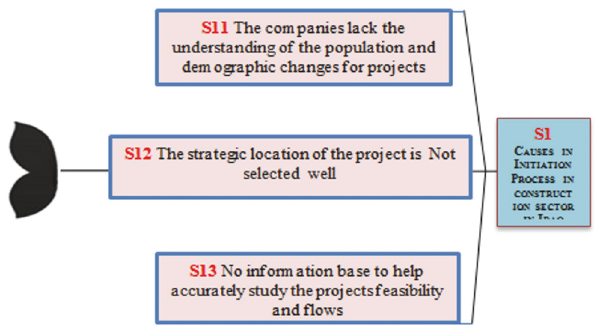
Figure 3: Fishbone diagram for project initiation management process